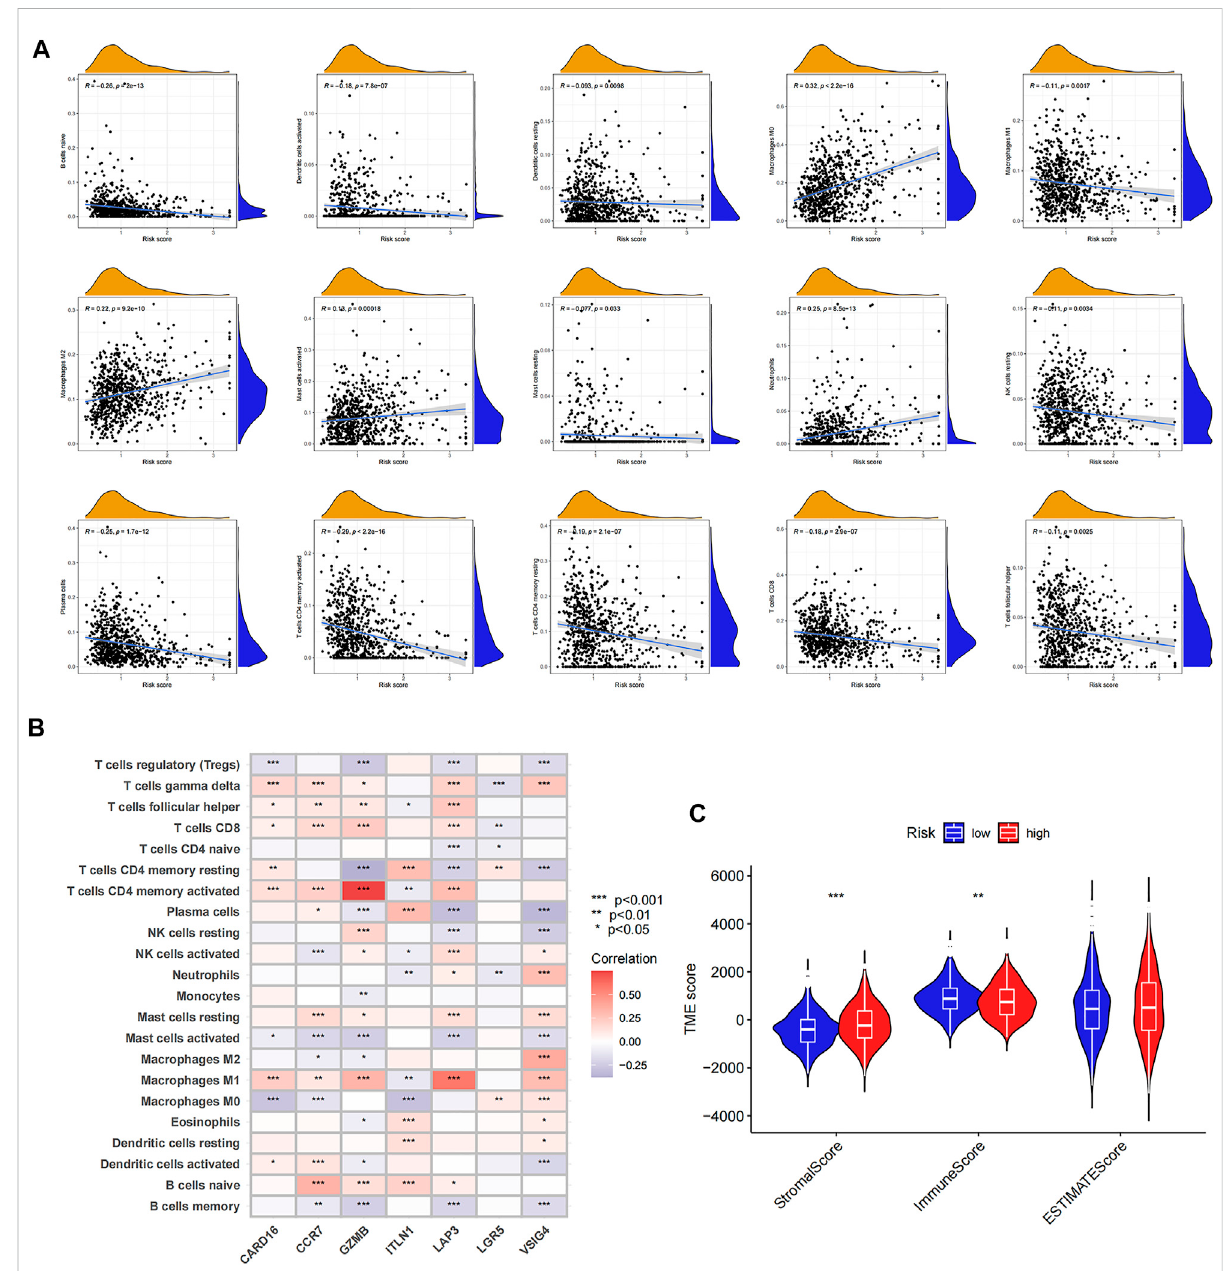
FIGURE 6 Evaluation of tumor microenvironment in high- and low-risk groups. (A) Relationship between risk score and different immune cell types. (B) Correlation between the abundance of immune cells and seven genes in the prognostic signature. (C) Correlation between risk score and immune- related scores. * p < 0.05; ** p < 0.01; and *** p <